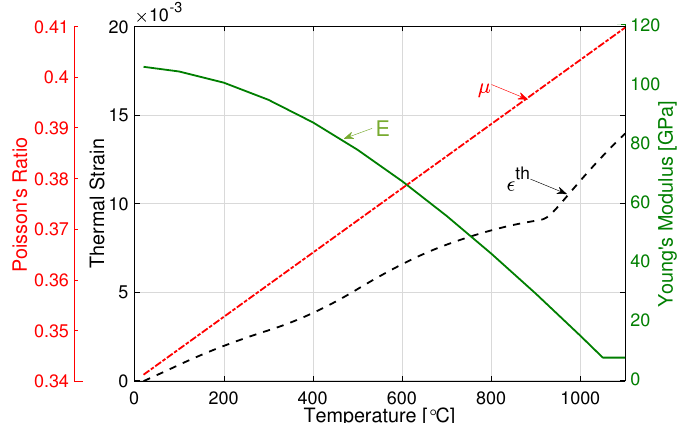
Figure 3. Poisson’s ratio ( µ ), thermal strain ( (cid:101) th ) and Youngs modulus